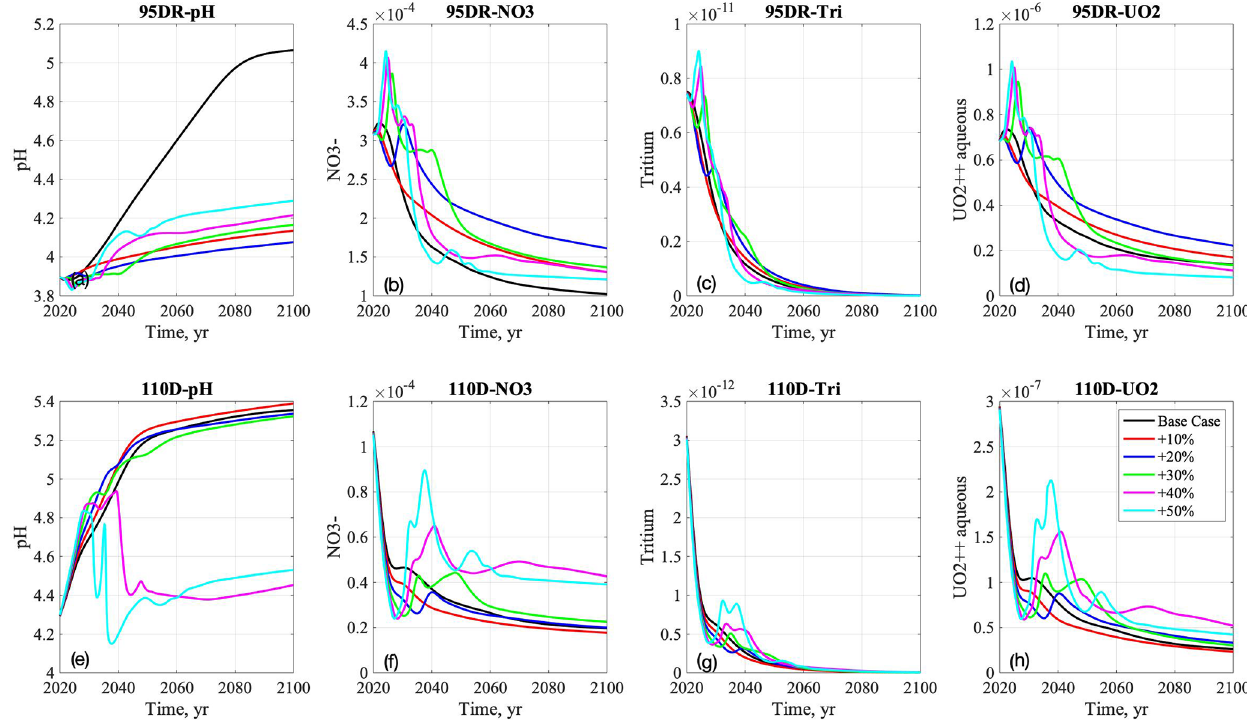
Figure 6. Breakthrough curves of pH, nitrate, tritium, and aqueous uranium at the source-zone well (a–d) and downgradient well (e–h) in the base case and increasing precipitation scenarios from 2020 to